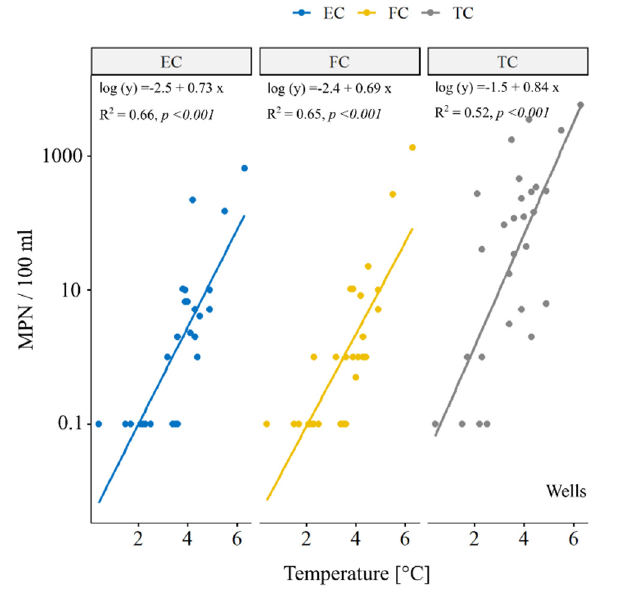
Figure 5. Relationship between temperatures and coliform concentrations in well samples. Please note that the y -axis is log-scaled.